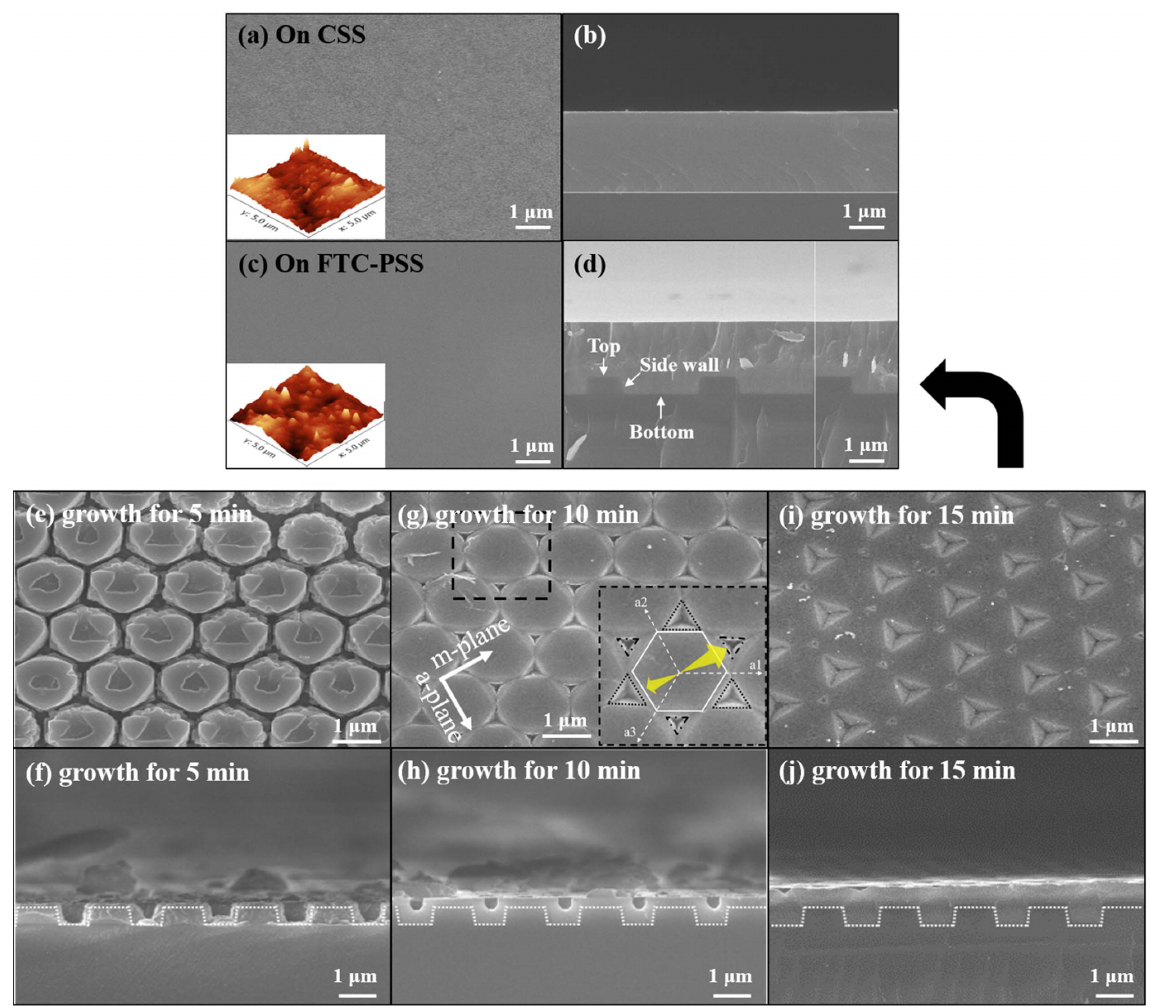
Figure 1 FE-SEM and AFM (inset) images of surfaces and cross-sections of the (cid:2) -Ga 2 O 3 epilayers grown on ( a )–( b ) CSS and ( c )–( d ) CF-PSS. Time evolution of (cid:2) -Ga 2 O 3 epilayers on CF-PSS at growth times of ( e )–( f ) 5, ( g )–( h ) 10 and ( i )–( j ) 15